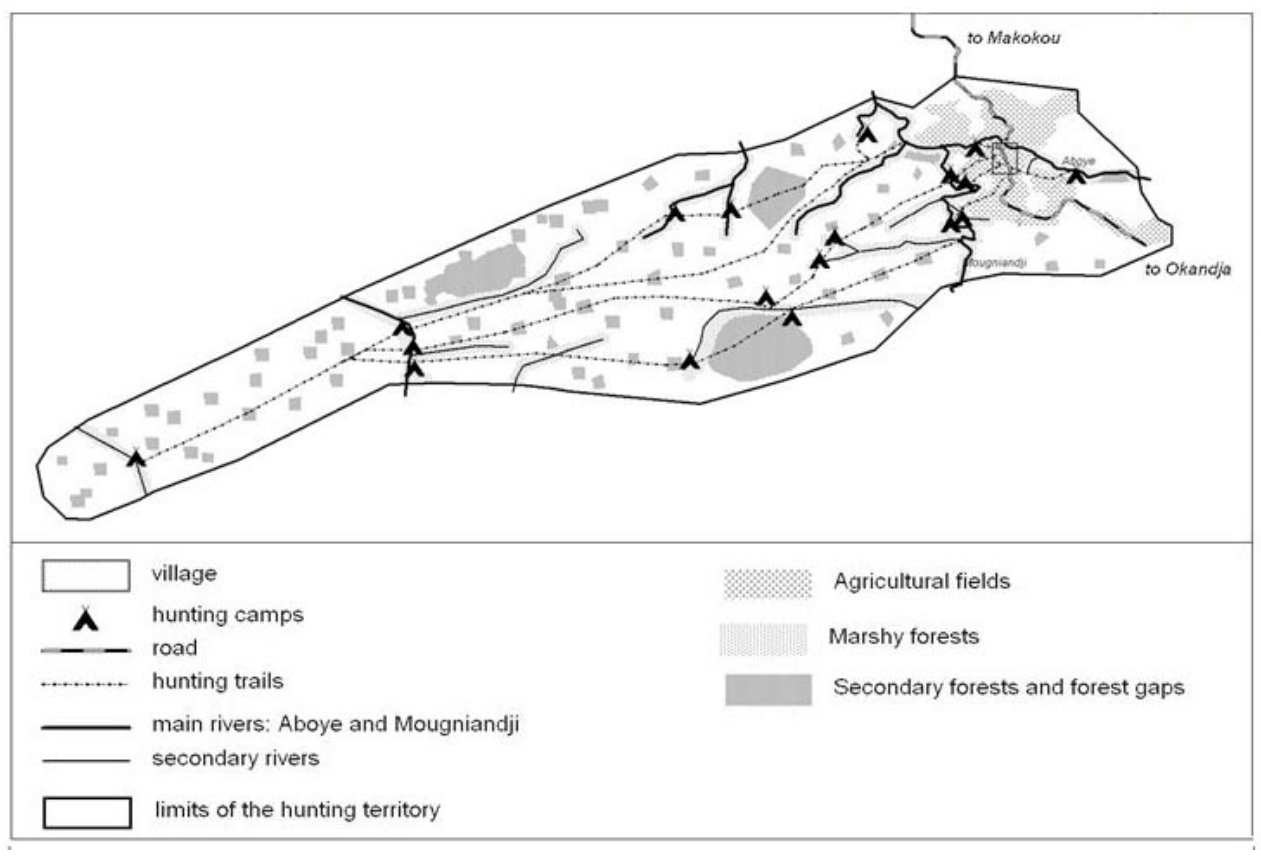
Fig. 2. Village boundaries, hunting trails, and hunting camps in